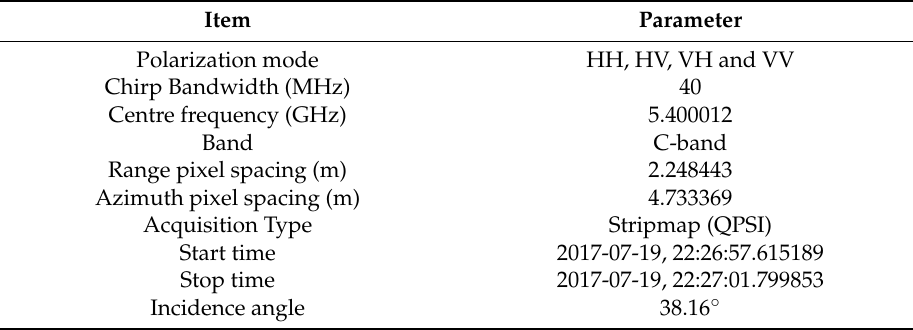
Figure 1. The location of the study area and the used data coverage, the yellow and orange rectangle denotes the GF-3 PolSAR data and the Sentinel-2A optical data, respectively. The red rectangles outline the experimental area. Table 1. Main imaging parameters of GF-3 satellite.